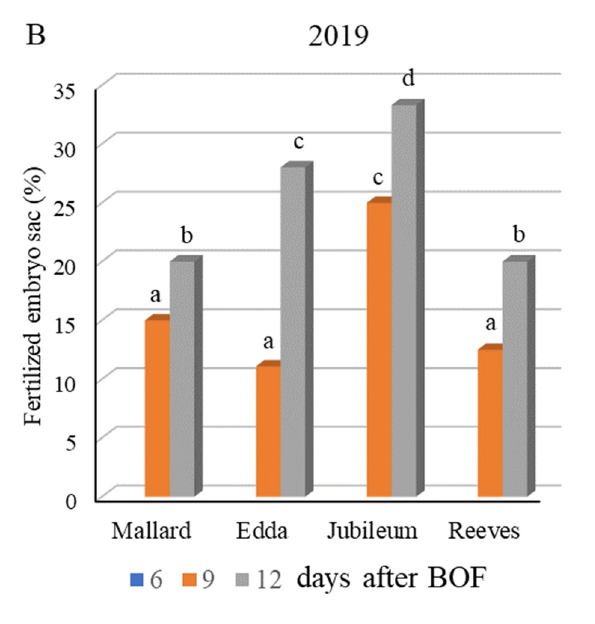
Figure 4. Percentage of fertilized embryo sacs in plum cultivars ‘Mallard’, ‘Edda’, ‘Jubileum’, and ‘Reeves’ in open-pollination conditions, during 2018 ( A ) and 2019 ( B ). (Different letters above the bars denote a significant difference between cultivars according to the LSD test, p < 0.05; asterisk (*) very significant differences).